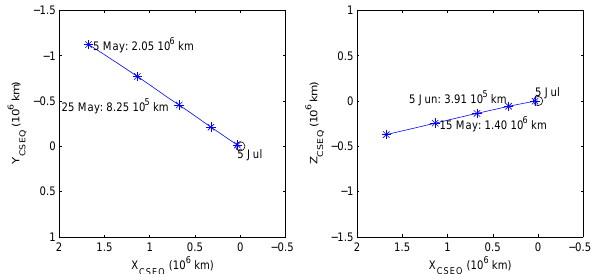
Fig. 1. The approach phase of Rosetta for the last 2 × 10 6 km in Fig.1. TheapproachphaseofRosettaforthelasttwomillionkminCSEQcoordinates. Asterisksindicatethe respectivedateandradialdistancefromthenucleus. CSEQ coordinates. Asterisks indicate the respective date and radial distance from the nucleus.